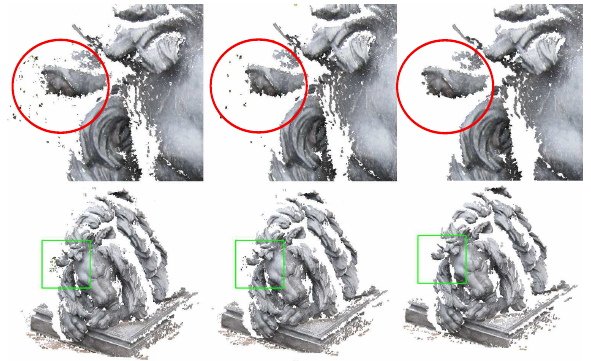
Figure 1: Point clouds corresponding to the filtered depth maps for different thresholds t . Figures in the upper row are detailed views of the area depicted by the green rectangles. Left: t s = 0 ; Middle: t s = 21 ; Right: t s = 41